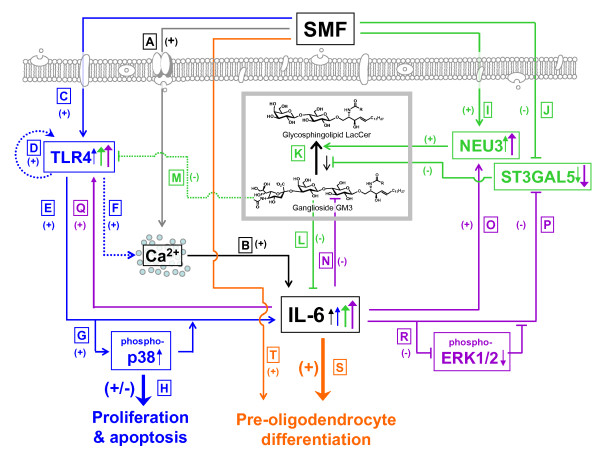
Overview of crosstalk between SMF and IL-6. Connections between SMF and IL-6 are shown in black, TLR4 in blue, gangliosides in green, feed-forward regulation of IL-6 on itself in purple, and whole cell responses (e.g., differentiation) in orange. Connections supported by data collected in this work are shown by solid lines (and the location of this data in subsequent figures is provided); dotted lines show connections based on the literature, as referenced. (A) SMF exposure modulates calcium flux (Fig. 3C and Fig. 11A). (B) Early increases in IL-6 mRNA levels (within 2 h, Fig. 3A) occur followed by increased levels of secreted IL-6 (within 7 h, Fig. 3B). (C) Likewise, SMF activates TLR4 (Fig. 3D), resulting in (D) feed-forward self-stimulation [41]. (E) In turn, TLR4 leads to IL-6 activation either through (F) a reported Ca2+-dependent route [39] or (G) through changes to p38 phosphorylation (Fig. 4A) that (H) transiently hinder proliferation in hEBD LVEC cells (Fig. 4B) without leading to apoptosis (Fig. 4C& D). SMF also has early-acting effects on NEU3 (I) and ST3GAL5 (J) mRNA levels (Fig. 8F) with (K) a concomitant decrease in ganglioside levels (Fig. 8B&C). (L) In the absence of SMF, exogenously-added ganglioside GM3 suppresses IL-6 production (Fig. 6A) and (M) TLR4 [38]. (N) IL-6 reduces ganglioside levels (Fig. 6B) through changes to (O) NEU3 and (P) ST3GAL5 mRNA levels (Fig. 7D) that (R) involve ERK1/2 phosphorylation (Fig. 7B&C). 'Downstream' responses to the combined administration of (S) IL-6 and (T) SMF include reproducible changes in cell morphology (Fig. 9E) and biochemical markers consistent with pre-oligodendrocyte differentiation (Fig. 10).